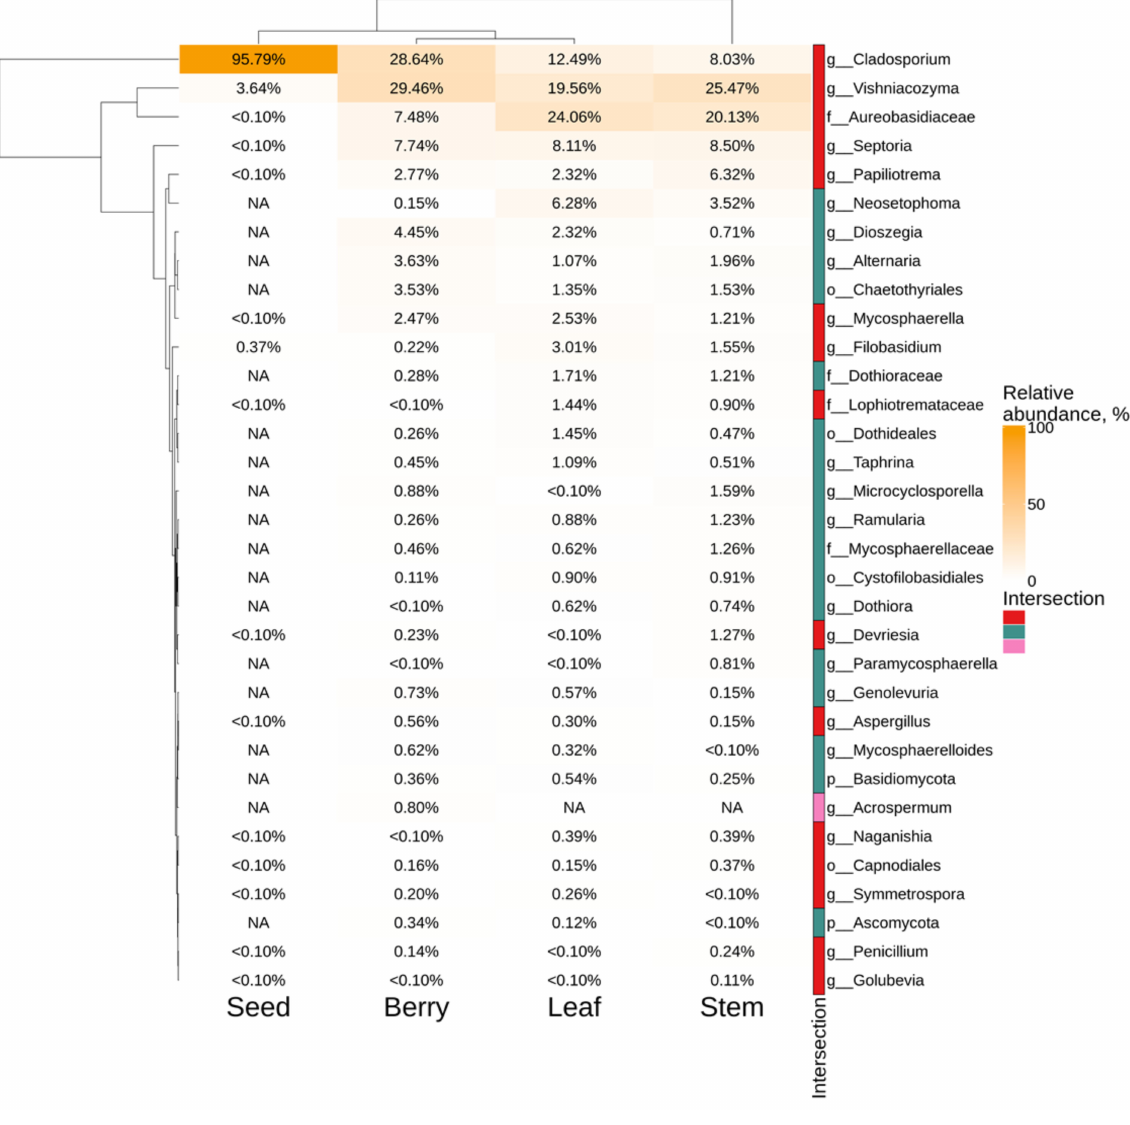
Figure 3. Genus level relative endophytic fungi abundance heat maps of significant taxa according to the next-generation sequencing (NGS) in different organs (seed, berry, leaf, and stem) of Vitis amurensis . The top 20 most abundant taxa from each factor are displayed. White squares (NA) represent the absence of taxa. The intersection selection was made based on the Figure